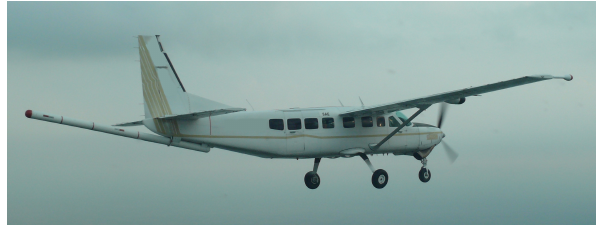
Figure 1. Example of the C208B model geophysical acquisition aircraft (source: E. Camara, author private collection, Septem- ber 2014).